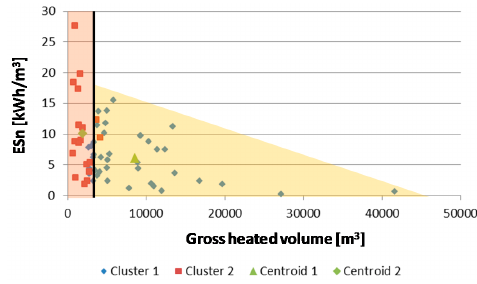
Figure 12. Declared energy savings (kWh/m 3 ) versus gross heated volume for the two